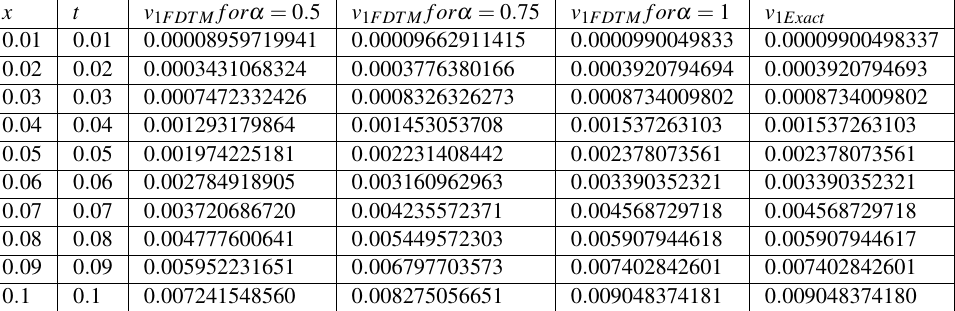
Table 2: Numerical solution of v 1 ( x , t )